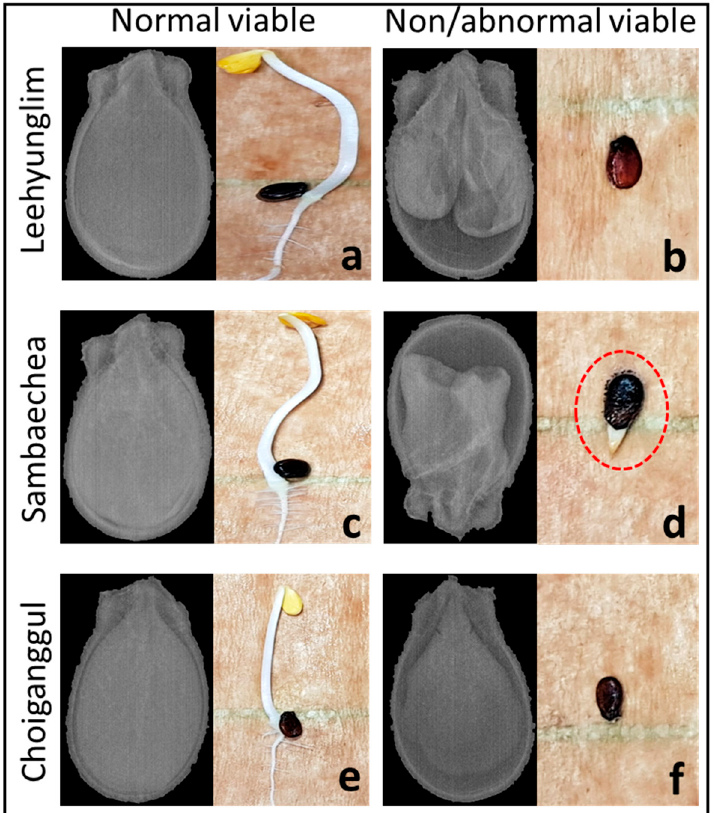
Figure 8. Morphological di ff erence in normal viable and nonviable and abnormal viable seed in 3 watermelon seed cultivars. Ehiongrim and Samveshay cultivars showed distinct morphological di ff erence than Suyegangkul. Seeds contained good shaped internal structures and produced healthy seedlings from all cultivars shown in ( a , c , e ). Poor internal structure seeds failed to germinate ( b , f ) or produce abnormal seedlings ( d ) (no proper root and shoot, mark with red dotted circle).